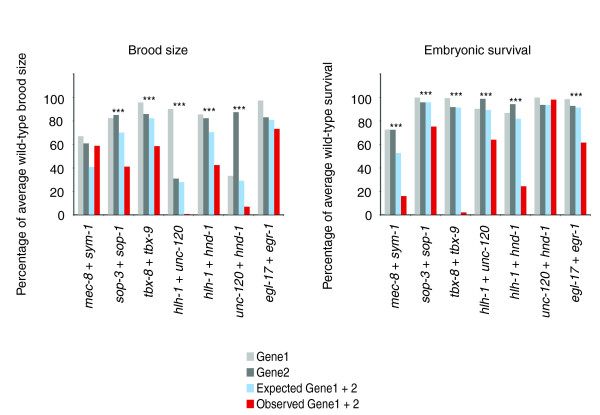
Combinatorial RNA interference (RNAi) can recapitulate known synthetic lethal interactions. To test whether combinatorial RNAi could recapitulate seven synthetic lethal interactions that were identified from literature (see Table 2 for references), brood size and embryonic survival measurements following co-targeting of both genes of a synthetic lethal pair (Observed Gene1 + 2) were compared with that following the targeting of each single gene alone (Gene1 or Gene2) and with the calculated product of the single gene brood sizes and embryonic survival measurements (Expected Gene1 + 2); this product represents the predicted outcome if the genetic interaction is purely additive. Values plotted represent the percentage of average wild-type brood size and embryonic survival rates, and are the arithmetic mean of two independent experiments performed in the RNAi-hypersensitive strain rrf-3 [19]. ***p < 1.0 × 10-02; *p < 5.0 × 10-02, by Student's t-test.